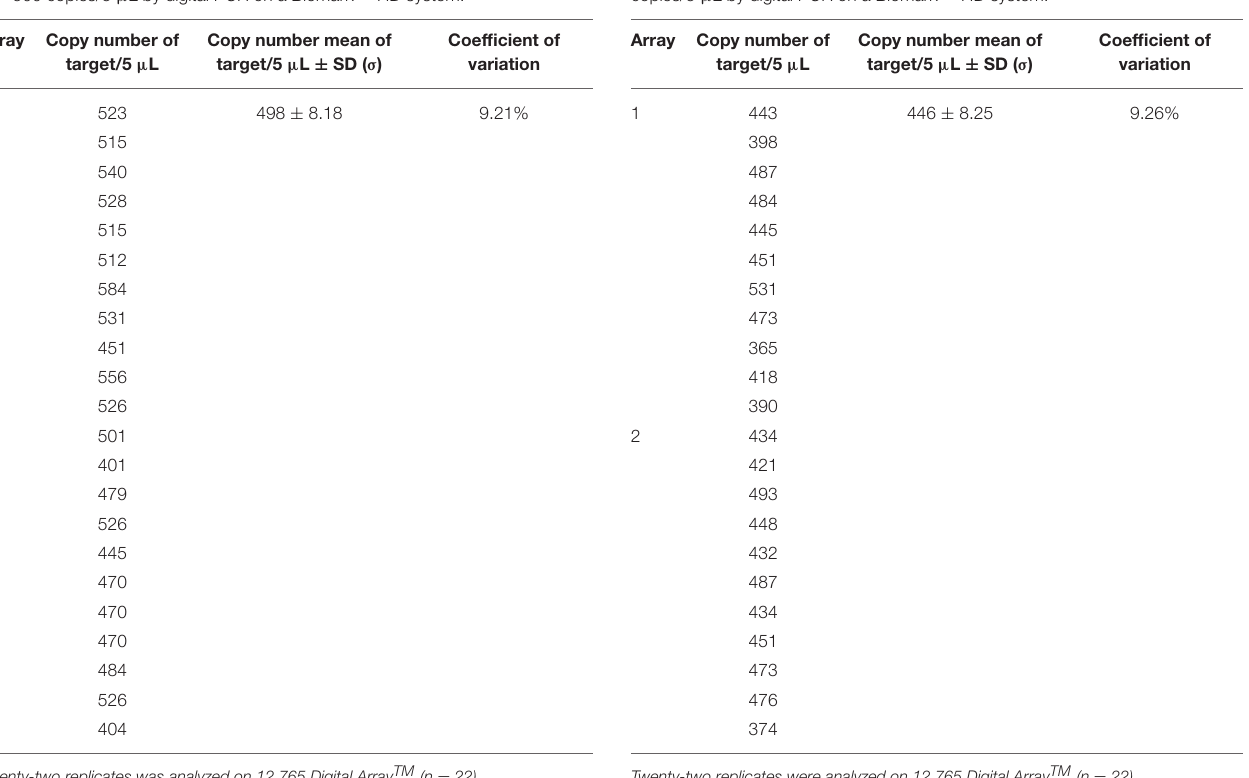
TABLE 6 | Copy numbers obtained on dilution of plasmid DNA at ∼ 500 copies/5 µ L by digital PCR on a Biomark TM HD system.